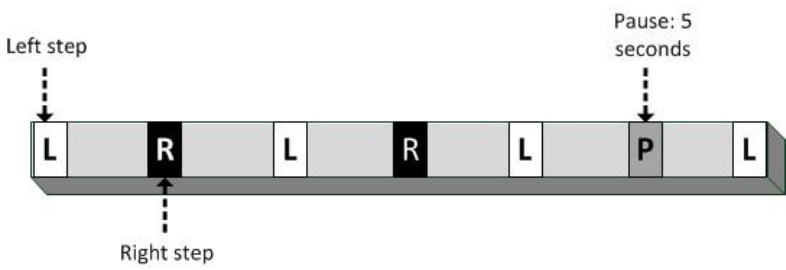
Figure 8. Segment used for signaling the path to the